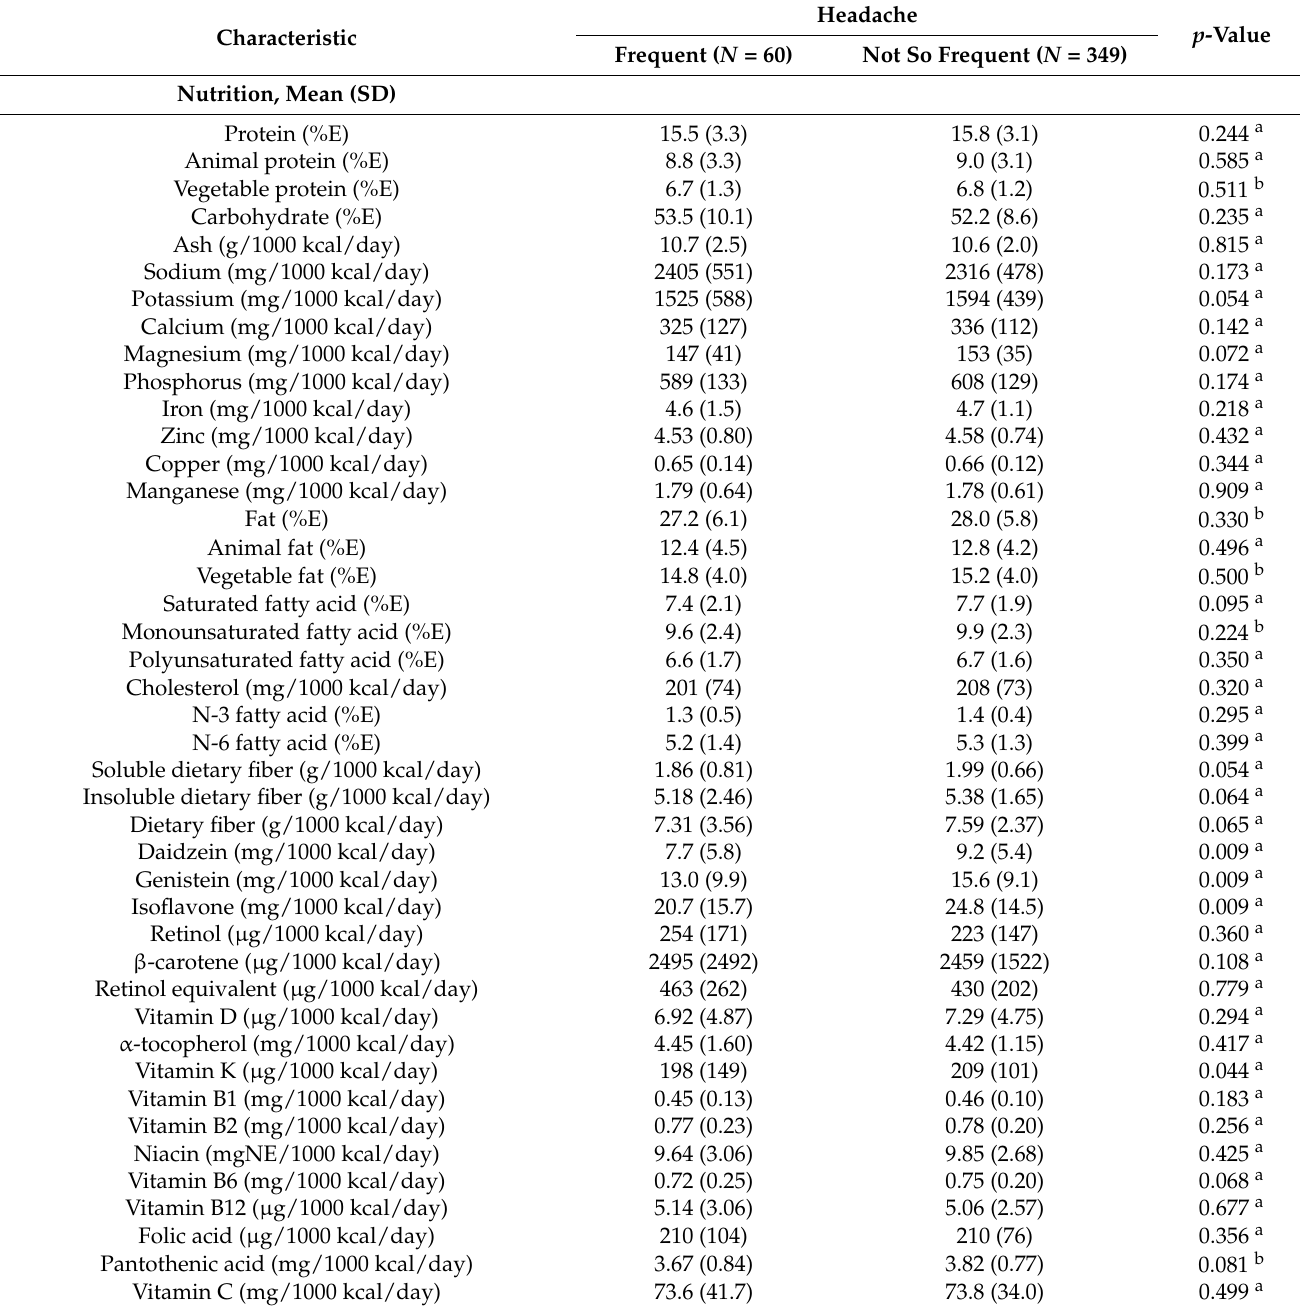
Table 2. Comparison of the daily intake of nutrients and the frequency of